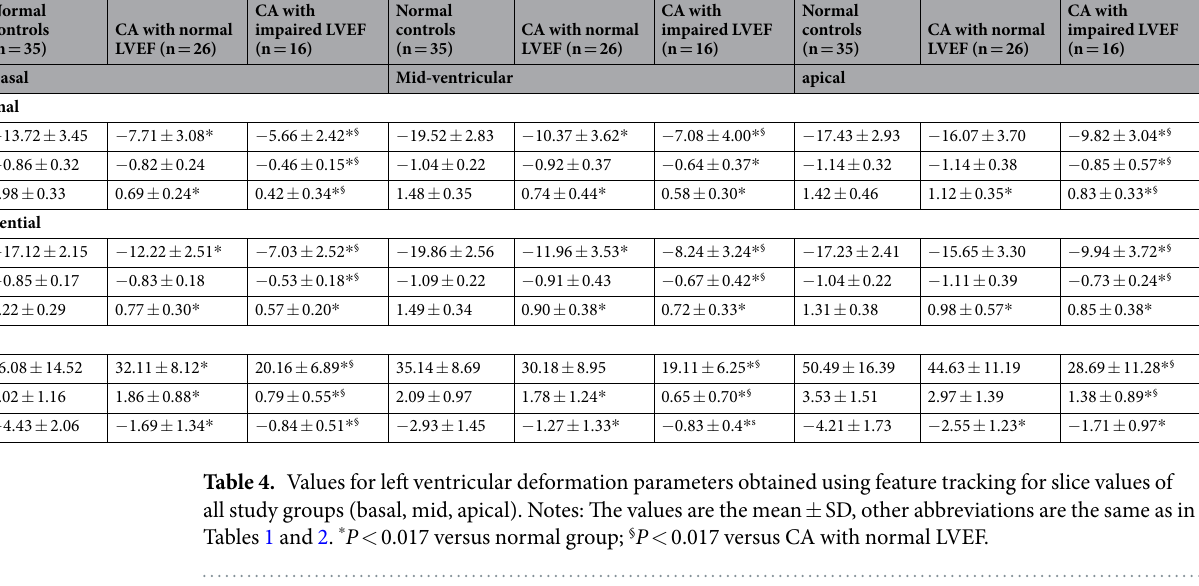
and TTM (39.79 ± 9.42 vs. 37.19 ± 13.80, P = 0.470; and 46.07 ± 10.08 vs. 46.68 ± 13.64, P = 0.867, respectively) were observed in mid-ventricular and apical slices. As demonstrated in Table 5, the LV longitudinal and circum- ferential PS and PSSR, and radial PDSR were inversely correlated to upslope and MaxSI in patients with CA. The longitudinal and circumferential PDSR, and radial PS and PSSR were significant and positive associated with perfusion slope and MaxSI.